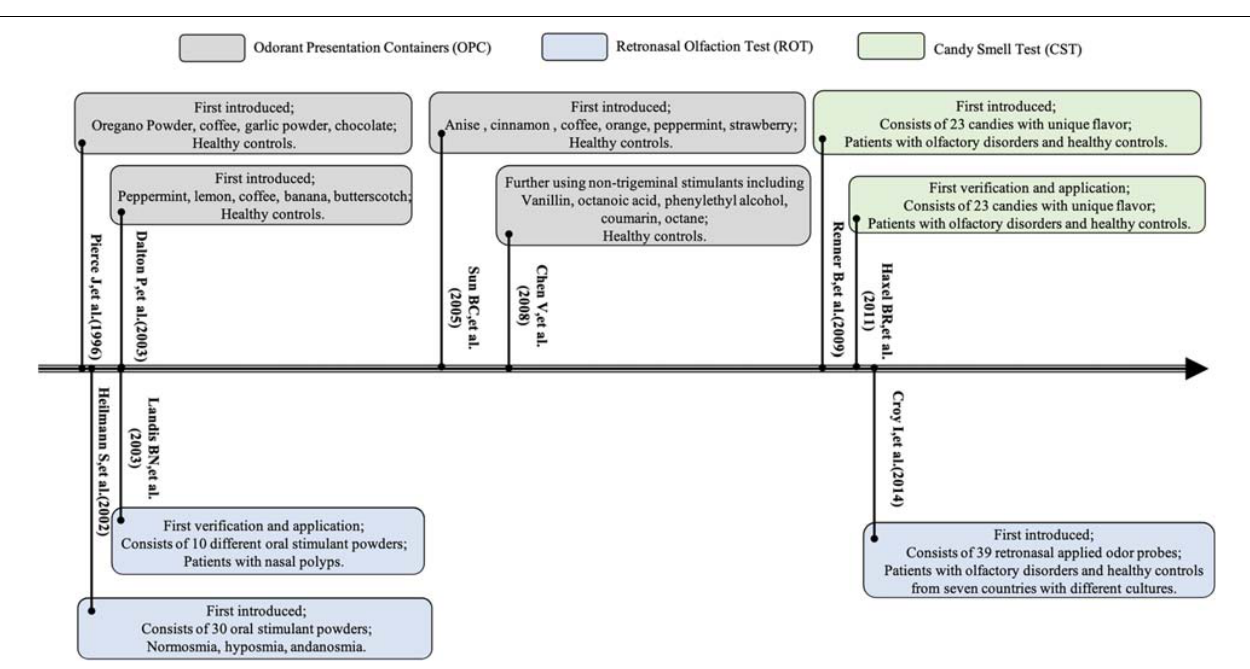
FIGURE 2 | Timeline for development of the retronasal olfaction tests between 1996 and